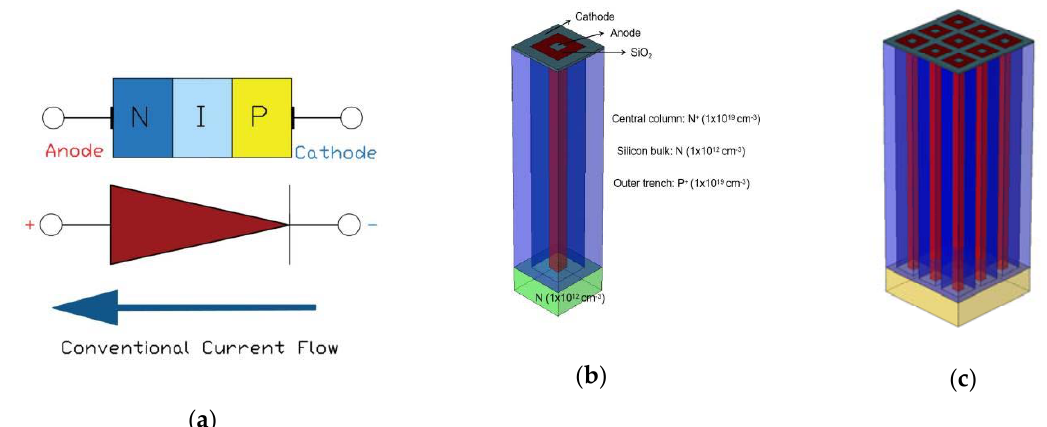
Figure 1. Structure schematic of the square ultra-fast 3D-Trench electrode Si detector; ( a ) Working principle of the detector; ( b ) Unit cell; ( c ) 3 × 3 array.